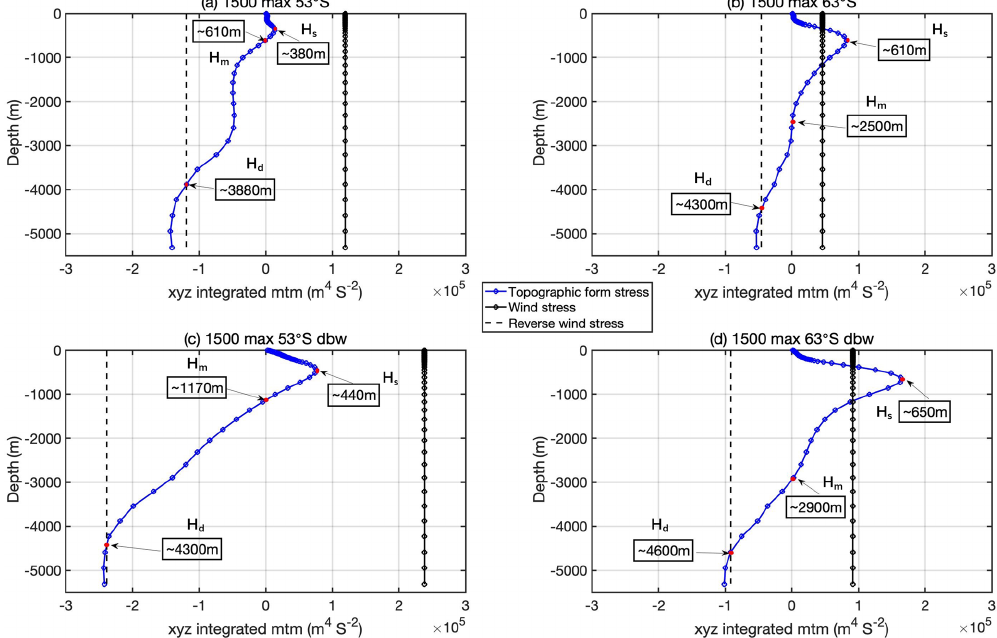
Figure 6. The comparison of horizontally integrated and vertically accumulated topographic form stress and wind stress in 1500_max_53 ◦ S (a) , 1500_max_63 ◦ S (b) , 1500_max_53 ◦ S_dbw (c) and 1500_max_63 ◦ S_dbw (d) cases. The blue curve is the topo- graphic form stress integrated from surface to various depths. The black line is the wind stress integrated from surface to various depths. The dashed line is the reversed wind stress integrated from surface to various depths (the same strength but opposite sign compared to depth-integrated wind stress). There are three unique depths indicated by red points in all four cases. The shallow depth ( H s ) is the first local maximum in the depth-integrated topographic form stress, which has the same sign as the integrated wind stress (e.g. 380m in a ). The mid-depth layer ( H m ) is where depth-integrated topographic form stress is zero (e.g. 610m in a ). The deep depth layer ( H d ) is where the depth-integrated topographic form stress intersects with reverse wind stress or has the same contribution but opposite sign compared to depth-integrated wind stress (e.g. 3880m in a